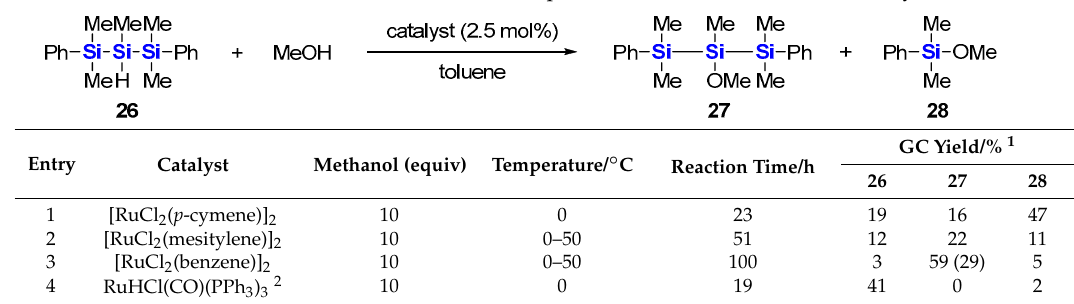
Table 2. Reactions of 26 with methanol in the presence of various ruthenium catalysts.